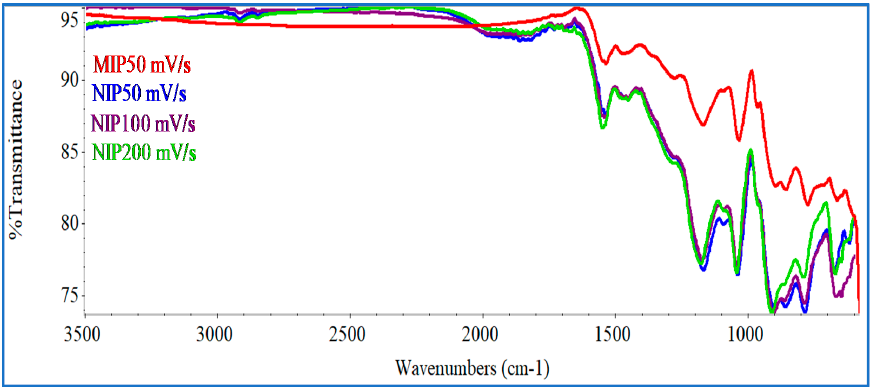
Figure 2. Fourier transform infrared spectroscopy (FTIR) spectra in full scale of the non-imprinted polymer (NIP) materials produced with different scan-rates (50, 100 and 200 mV/s).